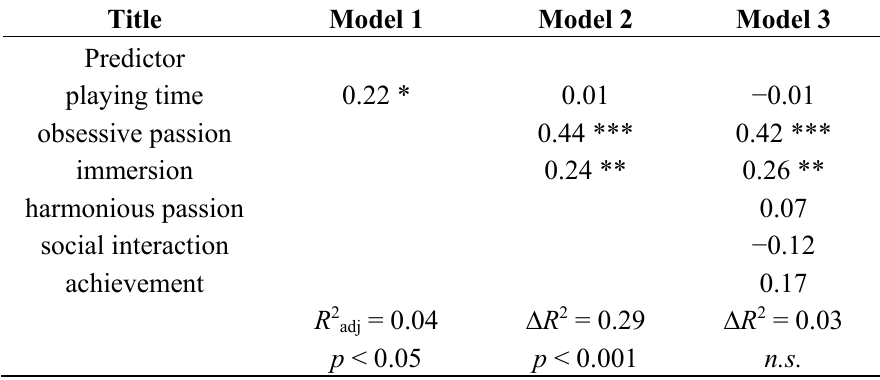
Table 2. Standardized beta weights and R 2 of the hierarchical regression analyses with ratings on the game addiction scale as